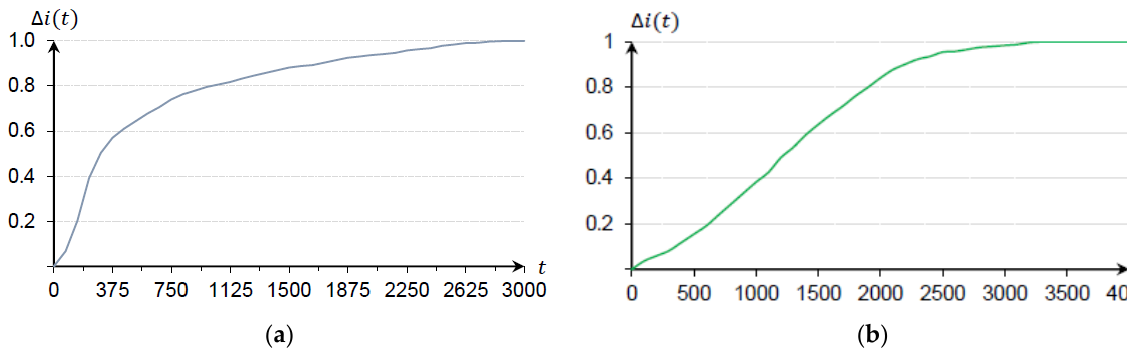
Figure 1. Change in enthalpy under disturbance of water flow rate: ( a ) for a once-through boiler; ( b ) for the boiler unit economizer.